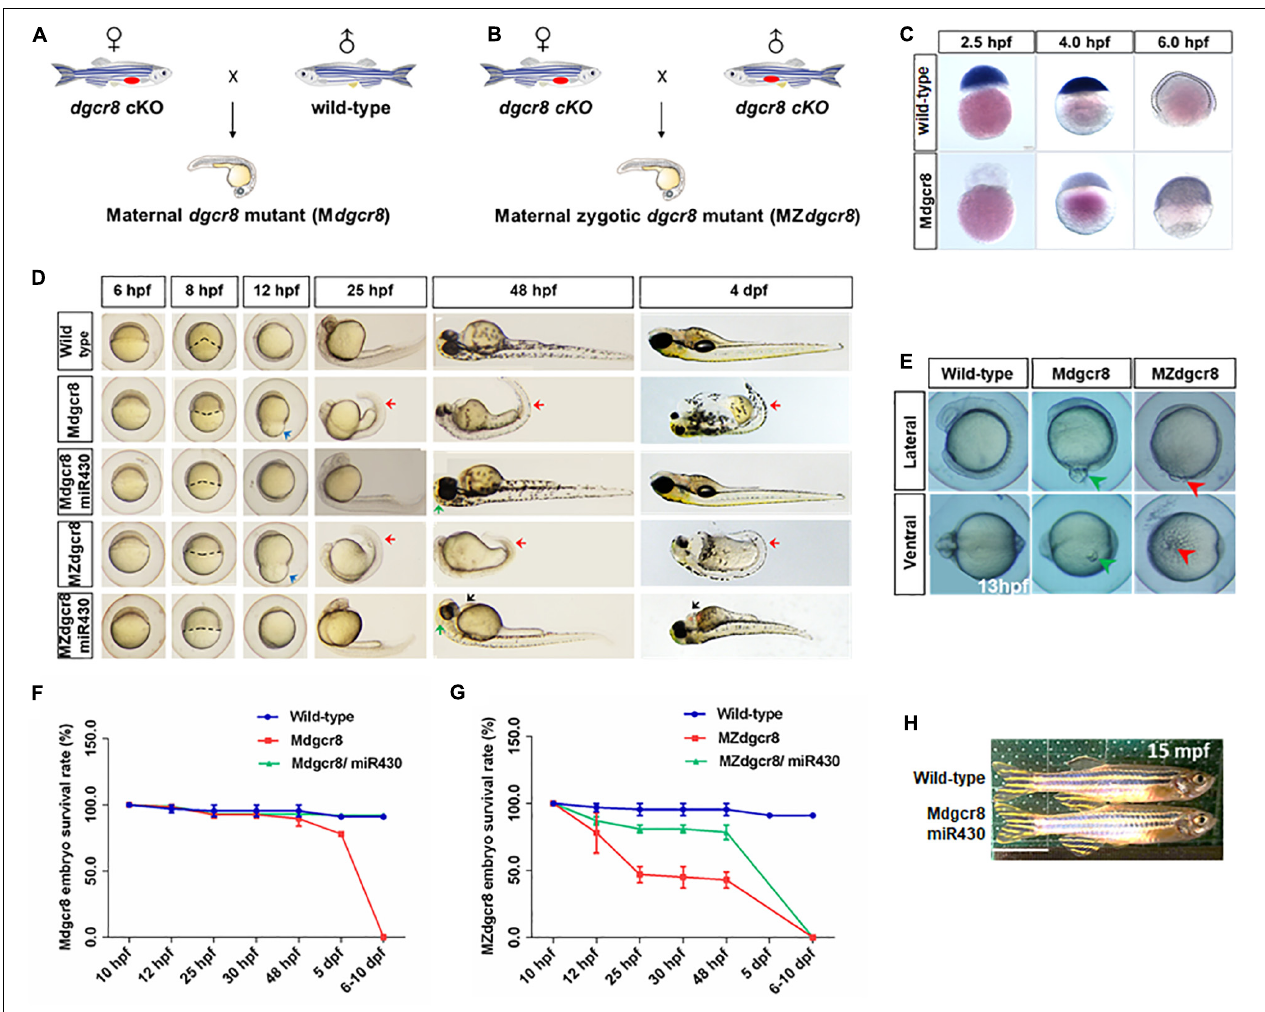
FIGURE 2 | Rescue of M dgcr8 and MZ dgcr8 using miR-430 duplex. (A) A schematic diagram of generating M dgcr8 mutant zebrafish by out-crossing with wild-type male. (B) A schematic diagram of generating MZ dgcr8 mutant zebrafish by in-crossing. (C) The expression of dgcr8 was analyzed by in situ hybridization in early embryonic stage. (D) M dgcr8 and MZ dgcr8 exhibit gastrulation defect, brain malformations, body curvature, and heart developmental defects compared with wild-type. miR-430 duplex was used to rescue the defects. (E) Epiboly defects in M dgcr8 and MZ dgcr8. At 14 hpf, the phenotype of yolk excision could be observed in MZ dgcr8 mutant (5 X), but not in M dgcr8 . (F) M dgcr8 embryonic survival rate become normal after rescue. (G) MZ dgcr8 mutant embryos only survived up to 6–10 dpf after rescue. (H) M dgcr8 mutant embryos after rescue could develop to adults and exhibit proper sex ratio. Scale bar 1